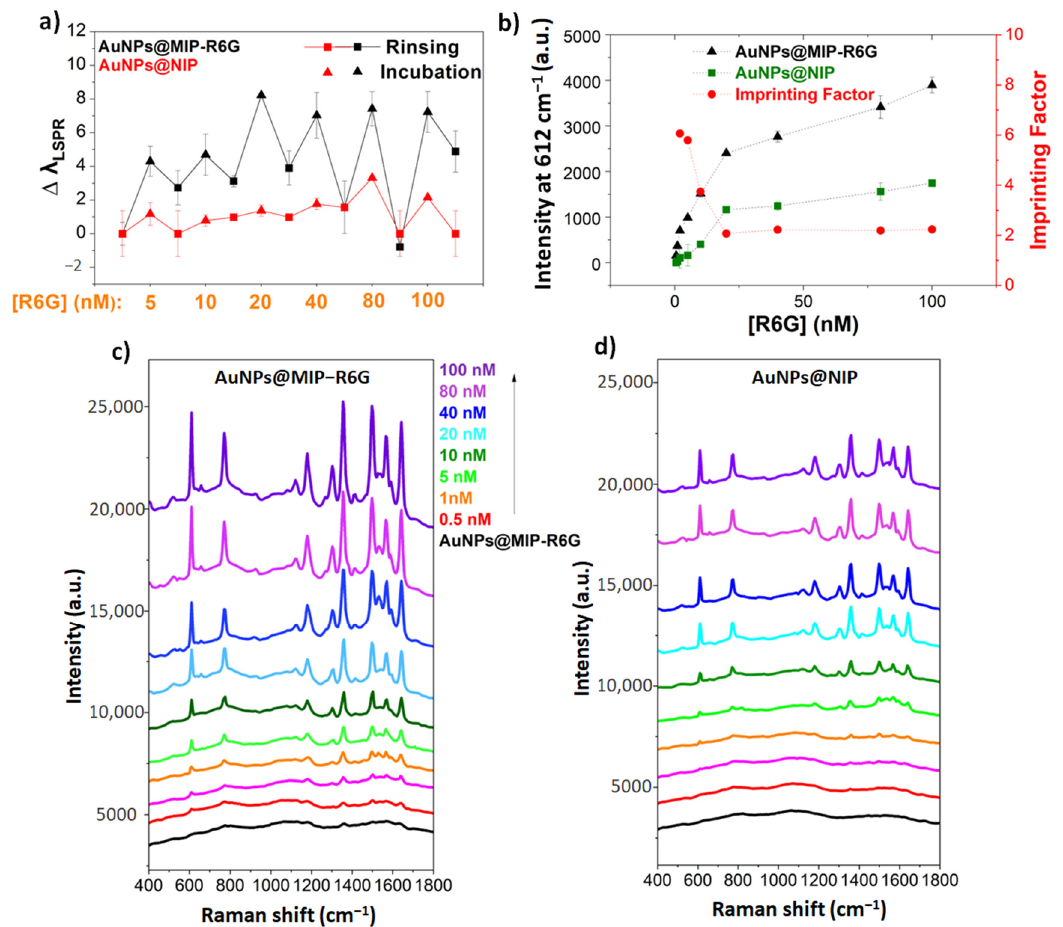
Figure 4. ( a ) Monitoring of R6G recognition by LSPR shift followed by UV-vis spectrophotometry in the case of MIP (black) and NIP (red), the triangles show the results after incubation and the squares after the rinses. ( b ) Plot of the SERS intensity for AuNPs@MIP-R6G and AuNPs@NIP and imprinting factor (IF) as a function of the R6G concentration ( c , d ) Monitoring of R6G recognition by SERS in the case of AuNPs@MIP-R6G and AuNPs@NIP respectively.